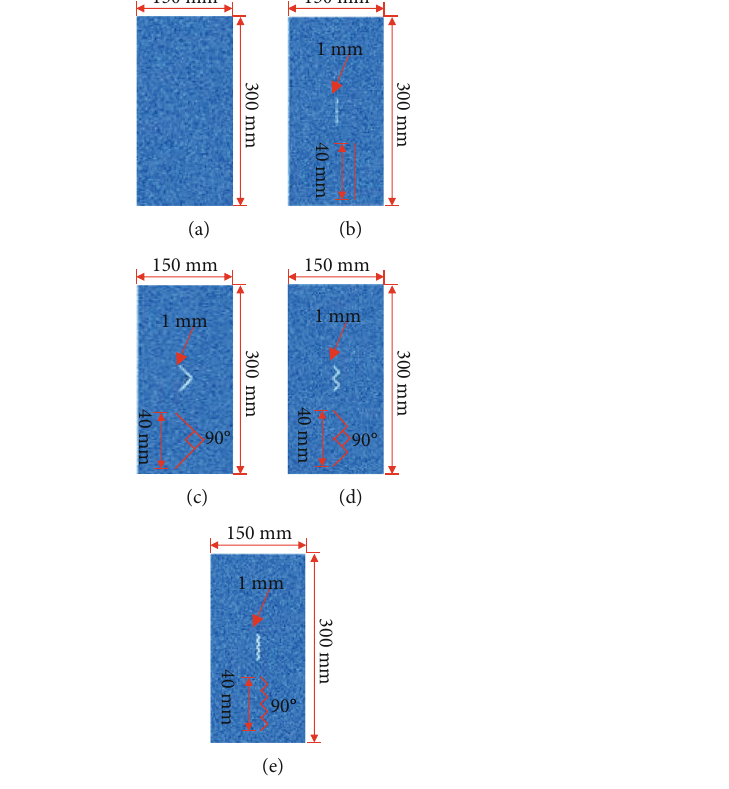
Figure 1: Initial model and model with preexisting cracks. (a) Initial model. (b) n = 0 . (c) n = 1 . (d) n = 3 . (e) n = 7 . Table 1: Microparameters for PFC 2D simulation of rock-like specimens. Parameters